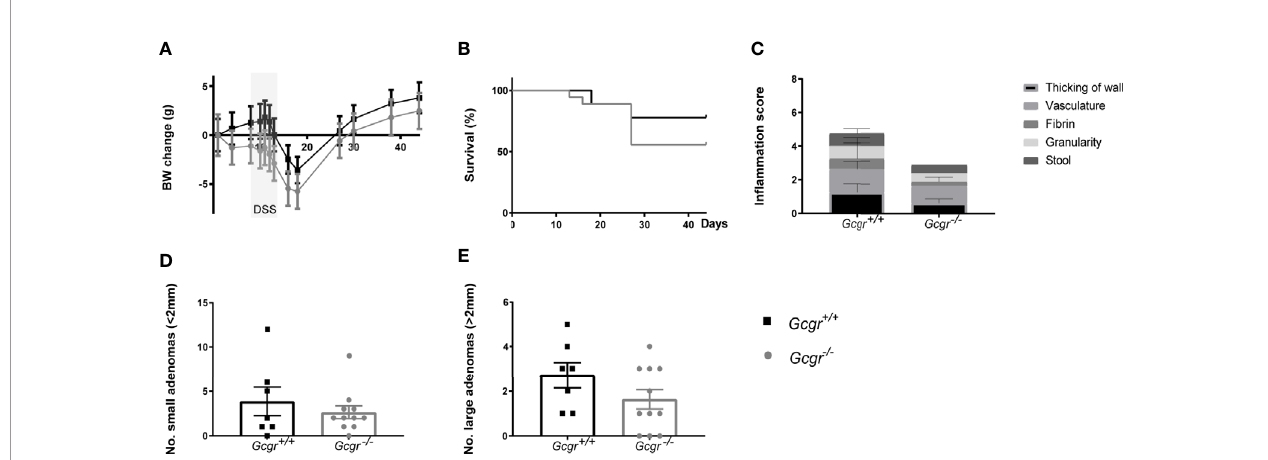
FIGURE 3 | AOM/DSS model in Gcgr − / − and Gcgr +/+ mice. Female Gcgr − / − mice (n=19) and their Gcgr +/+ littermates (n=8) received an intraperitoneal injection of azoxymethane (7.4 mg/kg), followed by one cycle of 3% DSS commencing day eight for six days. Body weight (BW) (A) was recorded once or twice a week. (B) Survival probability during the period of experimentation. (C) Murine endoscopic index of colitis severity, with a maximal score of 15. (D) The number of small adenomas per colon de fi ned as smaller than 2 mm in diameter. (E) The number of large adenomas per colon de fi ned as larger than 2 mm in diameter. Data were compared using a two-sided, unpaired students t-test or log-rank test and presented means ±